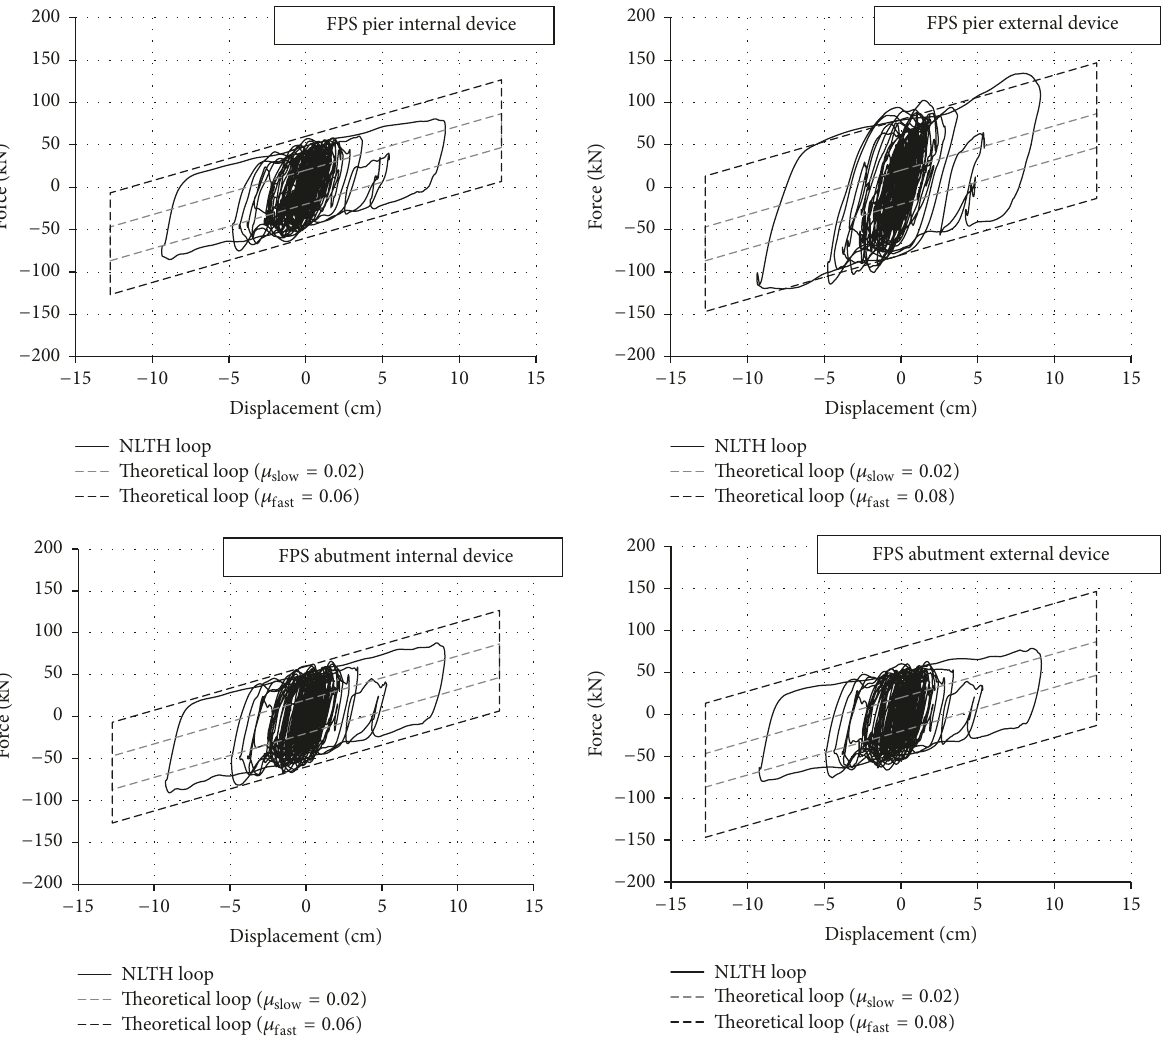
Figure 15: Comparison between theoretical and time history hysteresis loops, as effect of Irpinia earthquake along the transverse direction, for the FPD isolators placed at the top of pier columns and abutment